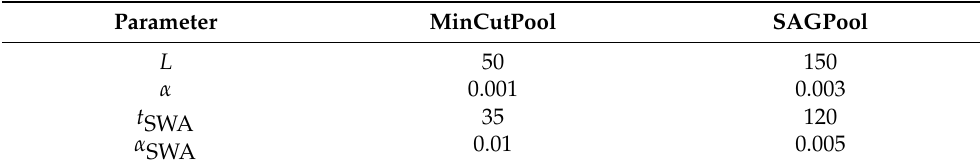
Table A3. The parameter settings for the graph-classification task on dataset D&D. The baseline optimizer was Adam with weight-decay factor of 0.0005. The variable L denotes the total number of epochs, α is the learning rate of the Adam optimizer, α SWA is the constant learning rate used by SWA, and t SWA is the starting point to launch SWA.